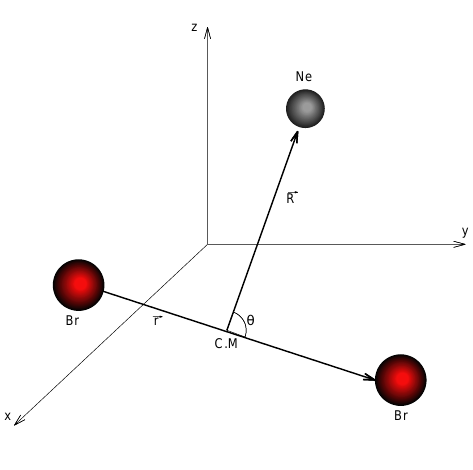
Figure 1. Jacobi coordinates for NeBr 2